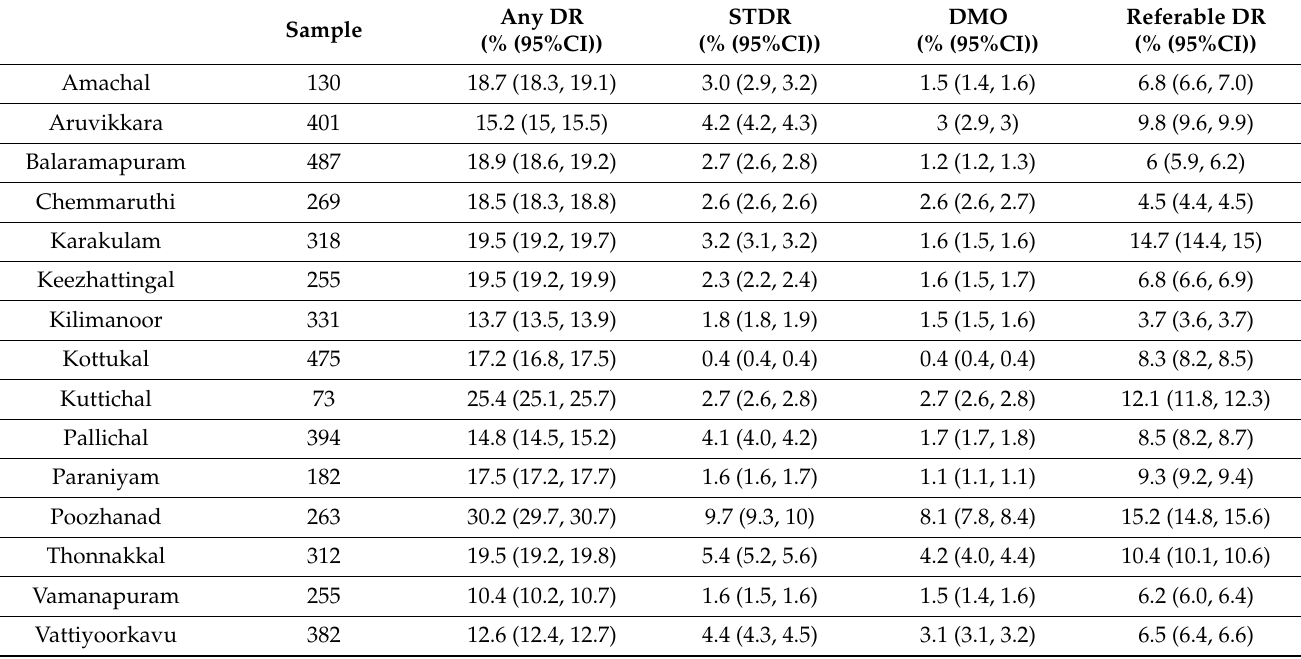
Table A1. Age- and gender-standardised prevalence of DR in each